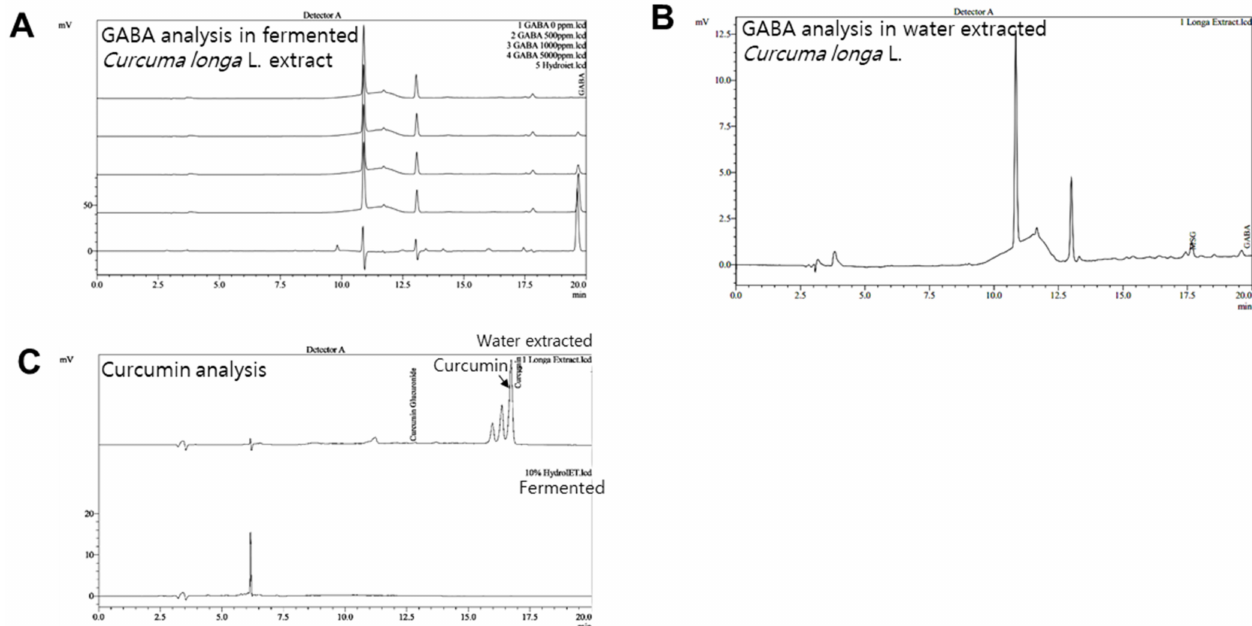
Figure 1. HPLC analysis of GABA in fermented and water extracted Curcuma longa L. extracts. Representative chromatograms of GABA standards (0, 500, 1000, and 5000 ppm) and fermented Curcuma longa L. extracts ( A ) and water extracted Curcuma longa L. ( B ). Representative chromatograms of curcumin; Curcuma longa L. water extract and fermented extract ( C ).